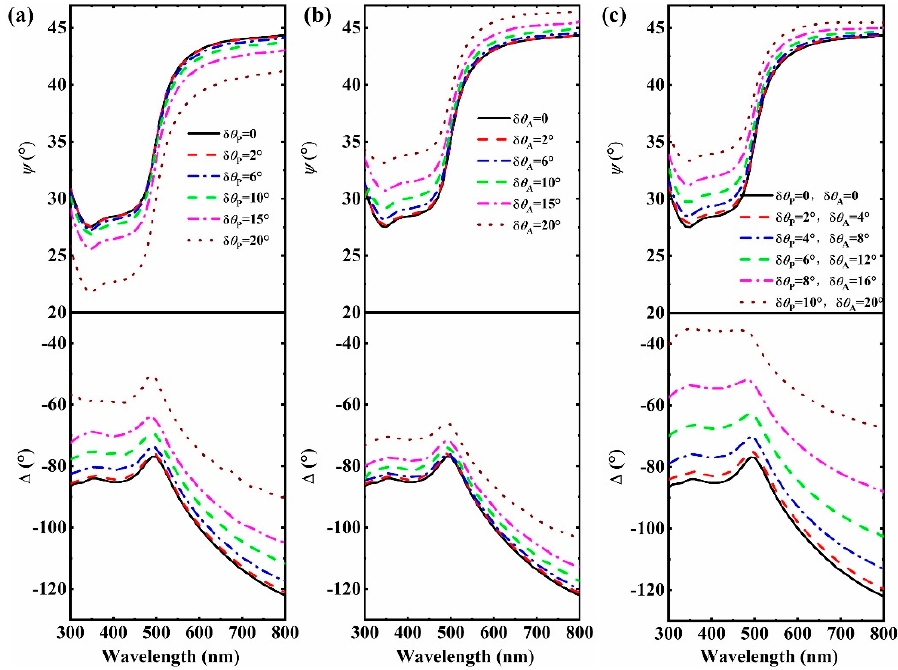
Figure 7. Measured ellipsometric parameters with various azimuthal errors of ( a ) the polarizer, ( b ) analyzer, and ( c ) both at a ratio of 1:2.